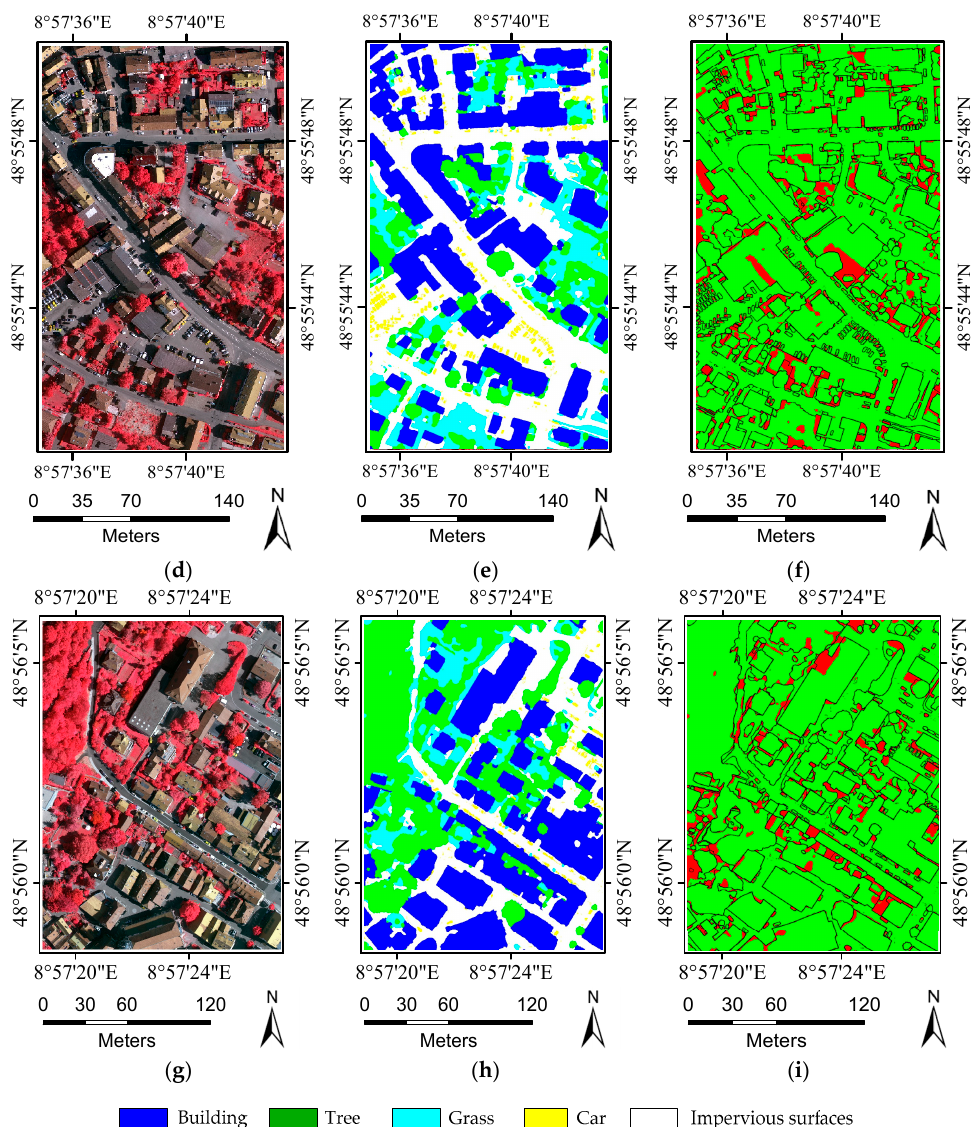
Figure 15. Classification results of 3 areas evaluated on the ISPRS unseen testing set. Right ( a , d , g ) The original TOP (for better comparison); middle ( b , e , h ) the classified results obtained by the proposed method; right ( c , f , i ) the red/green error map (red pixels indicate wrongly classified pixels).